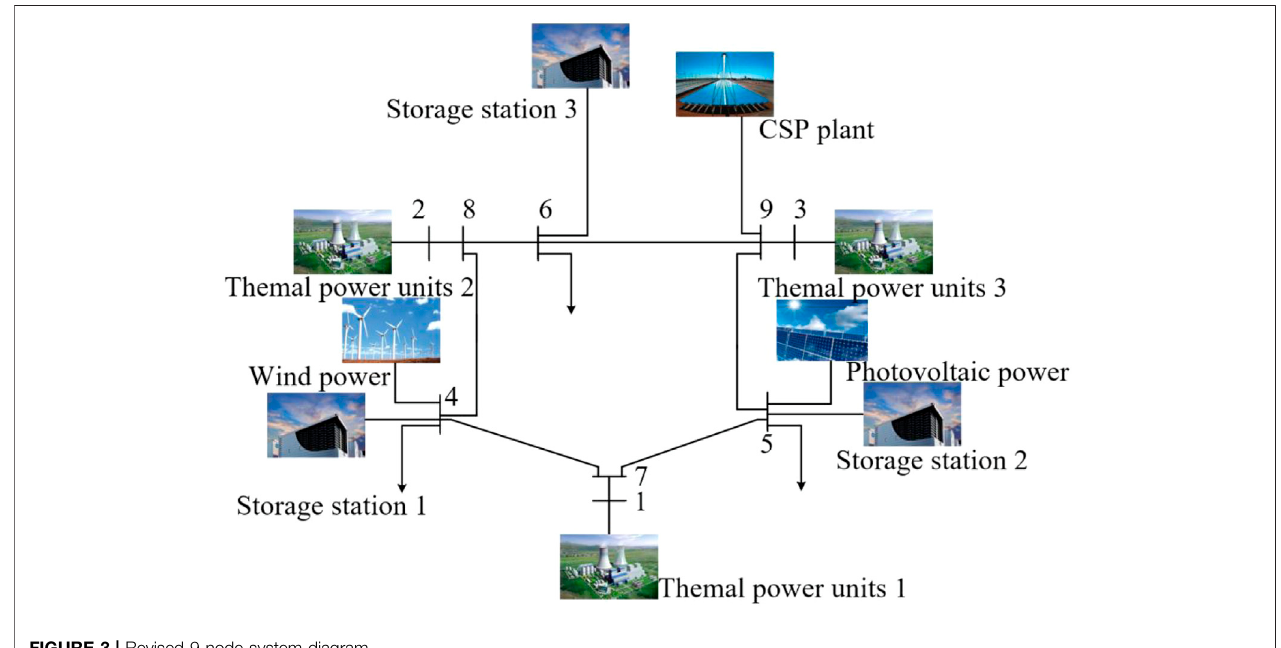
FIGURE 3 | Revised 9 node system diagram.